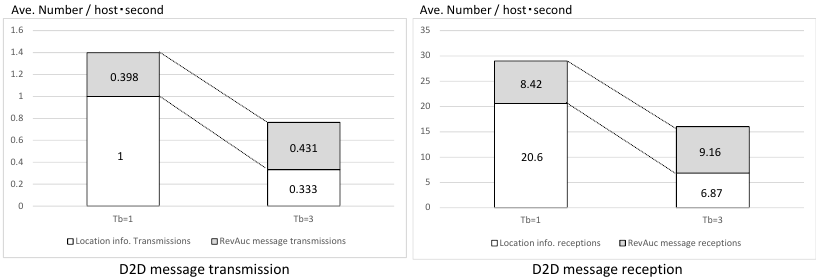
Figure 21. Number of different successful bids between 𝑇 𝑏 = 3 and 𝑇 𝑏 = 1 .